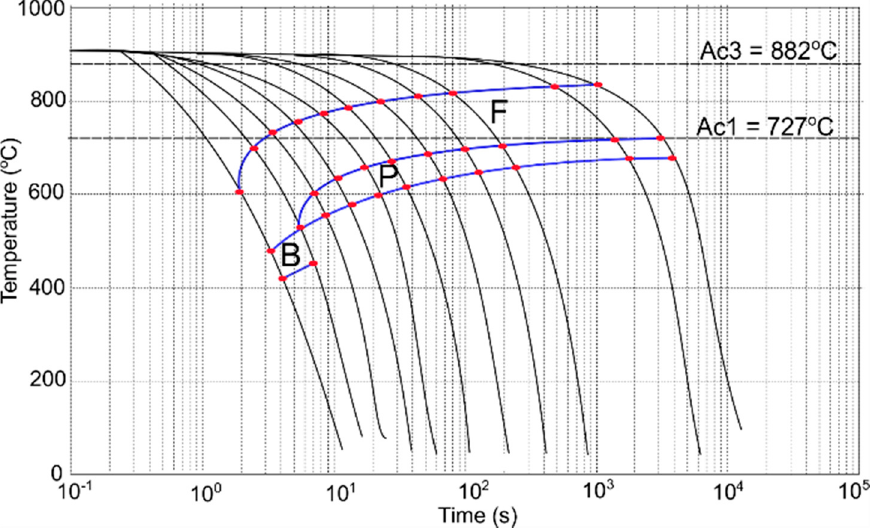
Figure 9. Continuous-cooling-transformation (CCT) diagram of the investigated low-carbon structural steel; blue lines denote the phase transformation zones.